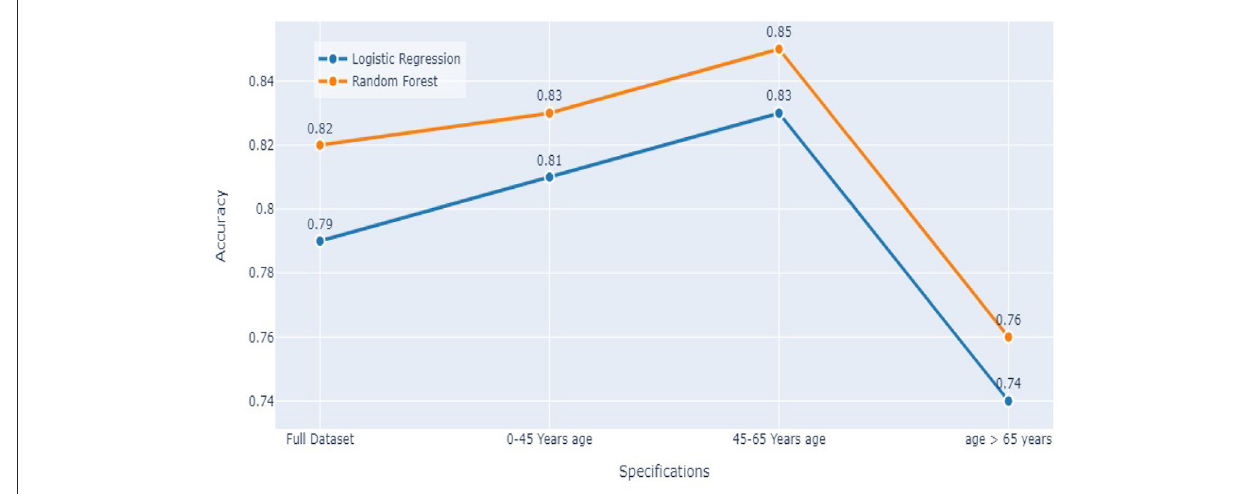
FIGURE7 Models accuracy comparison.